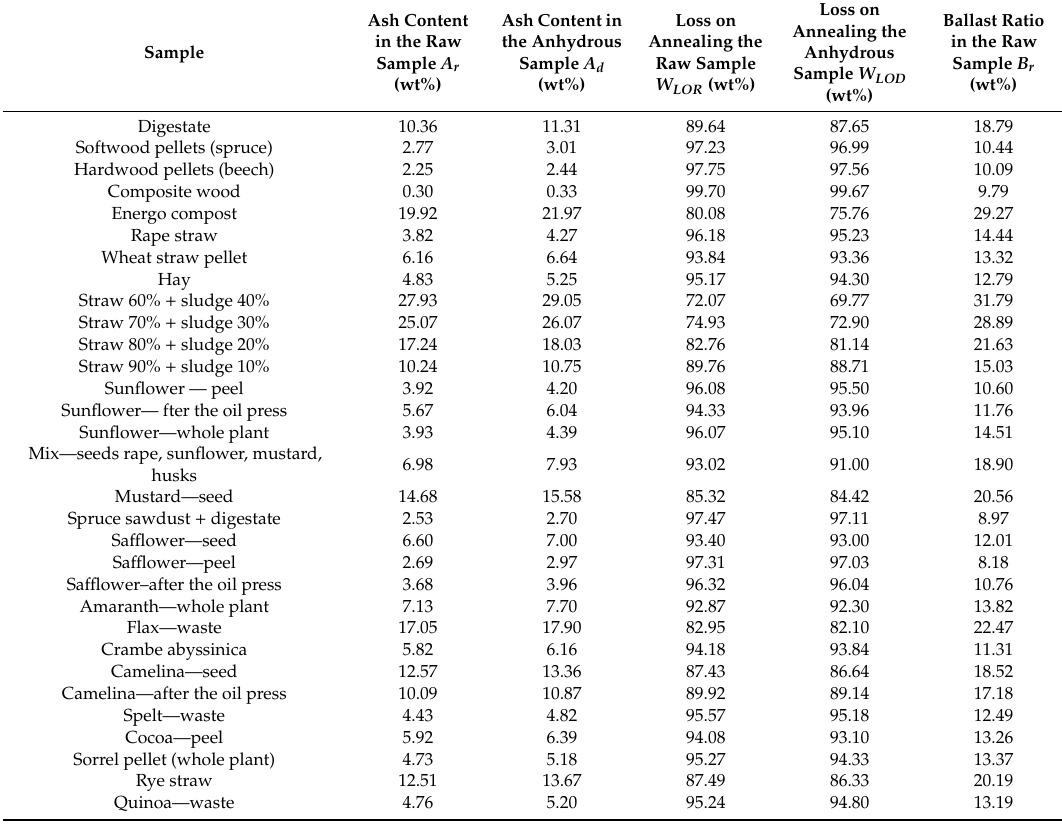
Table 2. Results of the determination of ash content, loss on annealing, and ballast ratio in samples.